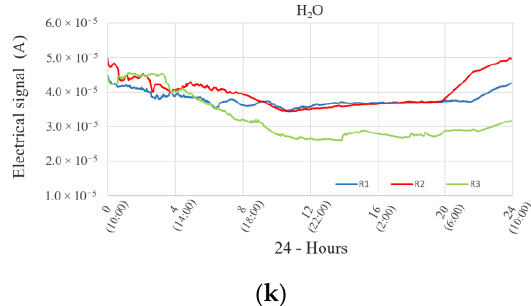
Figure 4. The electrical signals measured for different types of treatments during three phenological stages (R1, R2, and R3): ( a ) V1—MgSO 4 ; ( b ) V2—KNO 3 ; ( c ) V3—K 2 SO 4 ; ( d ) V4—Ca(NO 3 ) 2 ; ( e ) V5—